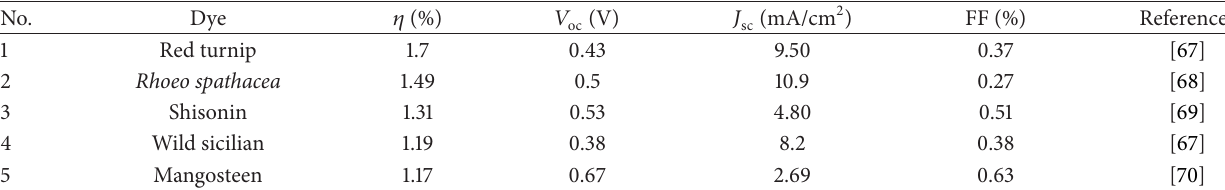
Table 3: Photoelectric parameters of DSSCs based on natural